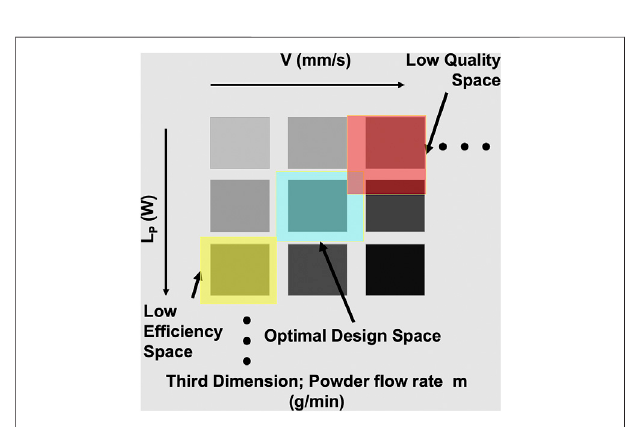
FIGURE 11 | A 3D landscape for the design of experiments (DoE) comprising the laser power ( L P ), scan speed ( V ) and the powder fl ow rate ( m ). A high laser power with a low velocity is inef fi cient, while a high velocity with a lowlaserpowerisdetrimentaltothedepositquality.Therefore,atradeoff between these parameters is important to achieve high quality